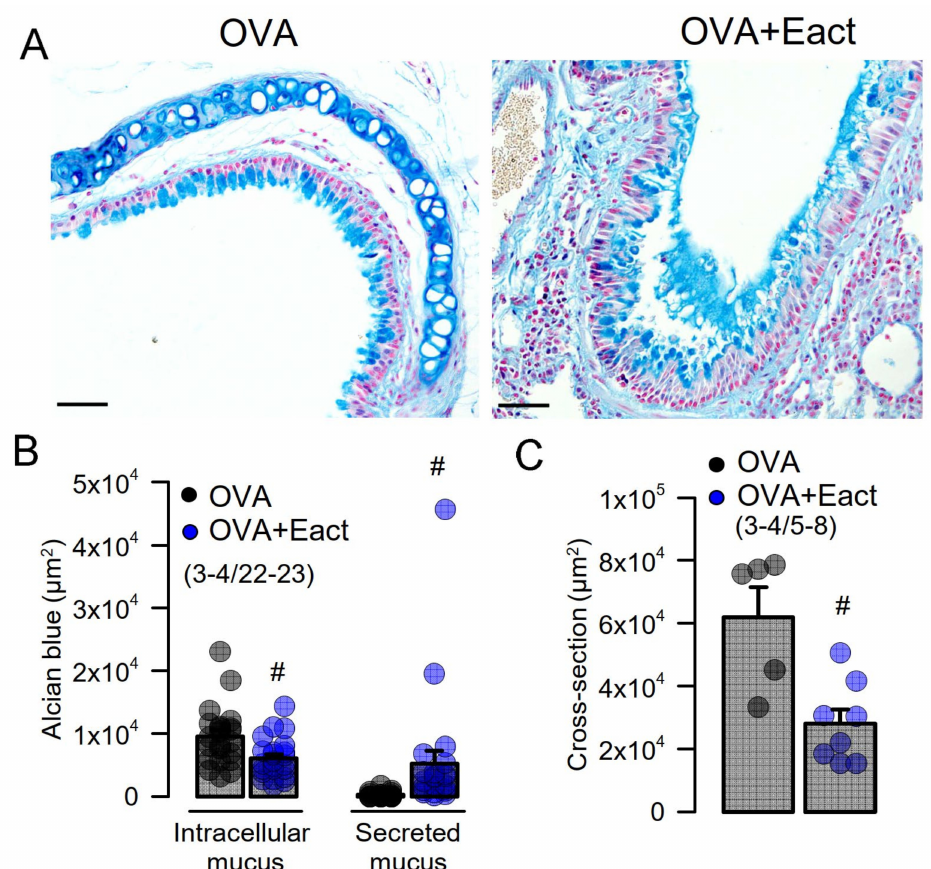
Figure 2. Activation of TMEM16A by Eact induces mucus release and airway contraction. ( A ) Mucus staining by alcian blue in OVA-treated asthmatic mice. Acute application of the activator of TMEM16A, Eact (4.8 µ g/mL intratracheal), induced acute release of mucus from goblet cells and increased intraluminal mucus. Bars indicate 50 µ m. ( B ) Summary of intracellular and intraluminal mucus. ( C ) Summary of cross sectional area indicating airway contraction by Eact. Mean ± SEM (number of animals/number of measurements). # significant difference when compared to control ( p < 0.05, unpaired t